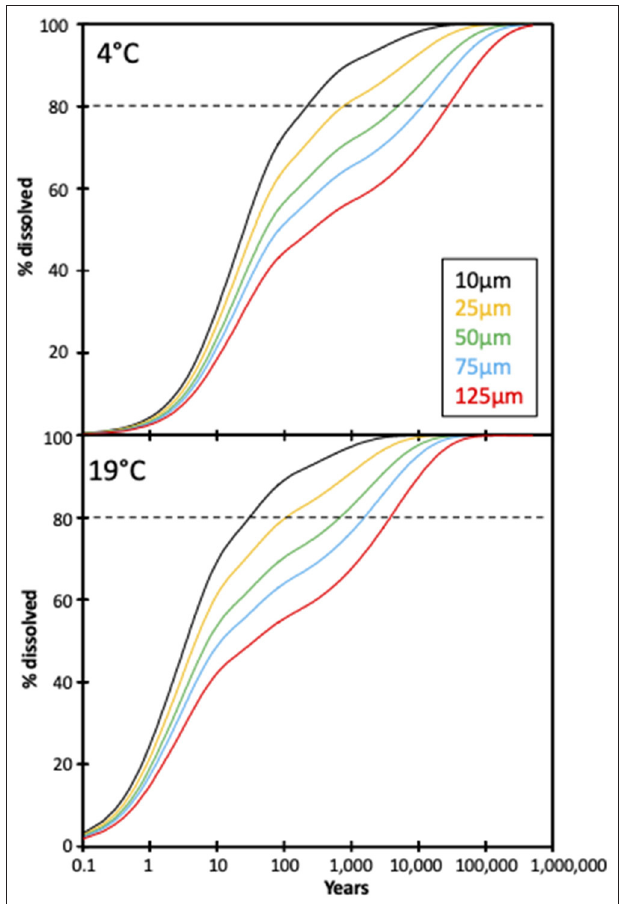
FIGURE 7 | Modeled extents of dissolution for different olivine grain sizes based on a shrinking core model (see text for details). The horizontal dashed lines represent a target dissolution proportion of 80% (given that the final 20% take a significant amount of time to finally dissolve).